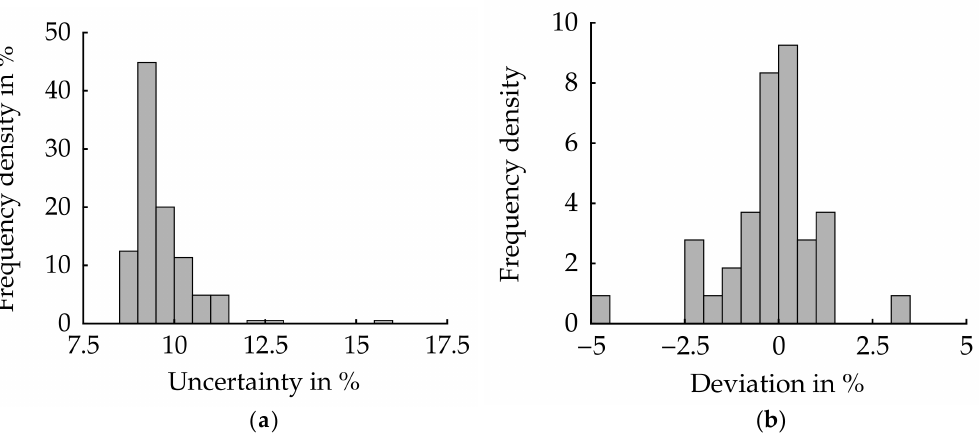
Figure 6. Detailed uncertainty analysis including linear propagation of uncertainties and repeatability of the experiments. ( a ) Nusselt number uncertainty for all measurements. ( b ) Deviation between repeated